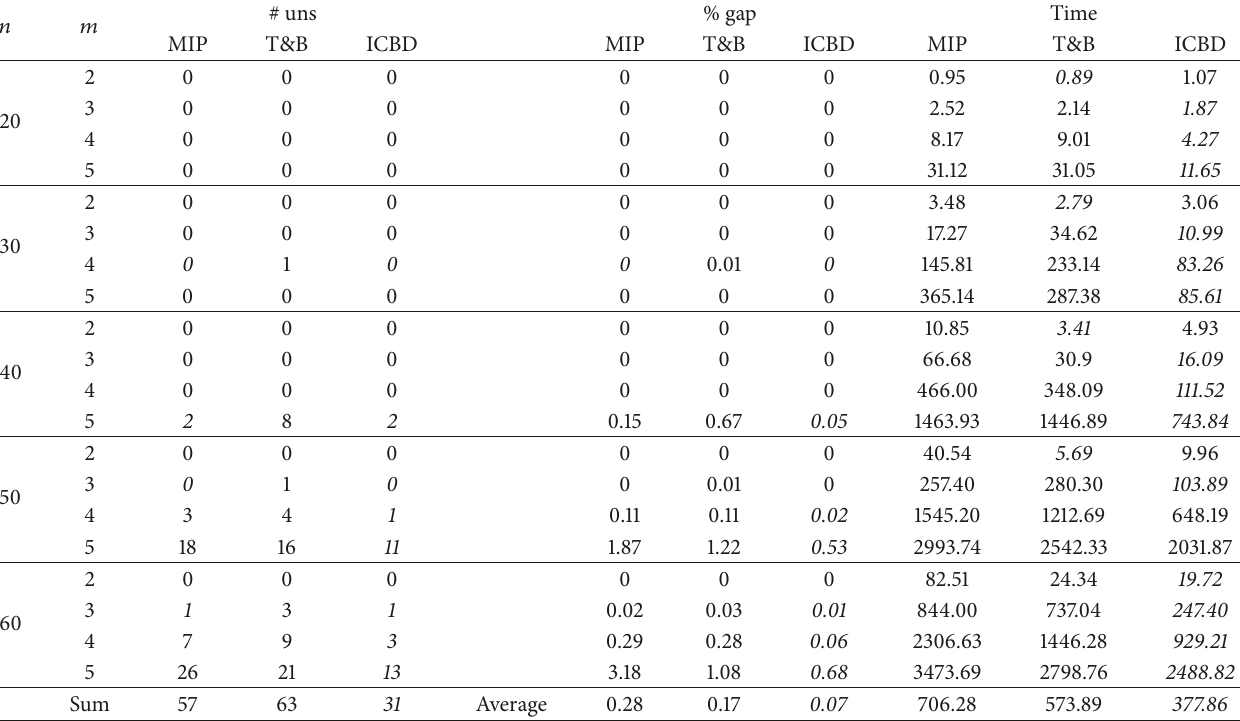
Table 3: Comparison of the MIP, T&B, and ICBD methods based on the number of unsolved instances, average gap, and execution